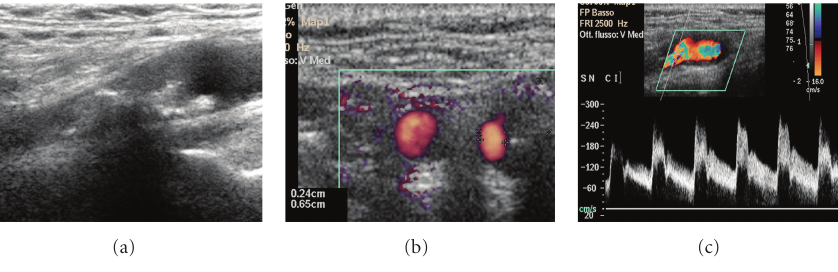
Figure 2: Left carotid stenosis demonstrated on Duplex US (Case 1) (a). Measurements of minimal lumen diameter (b) and Spectral US Evaluation with PSV Measure (c). The data obtained by Duplex US shows a high rate correlation with CTA measurements, with a stenosis of 80% evaluated according to strandness criteria and 79% with advanced vessel analysis (AVA) software at CT angiography.